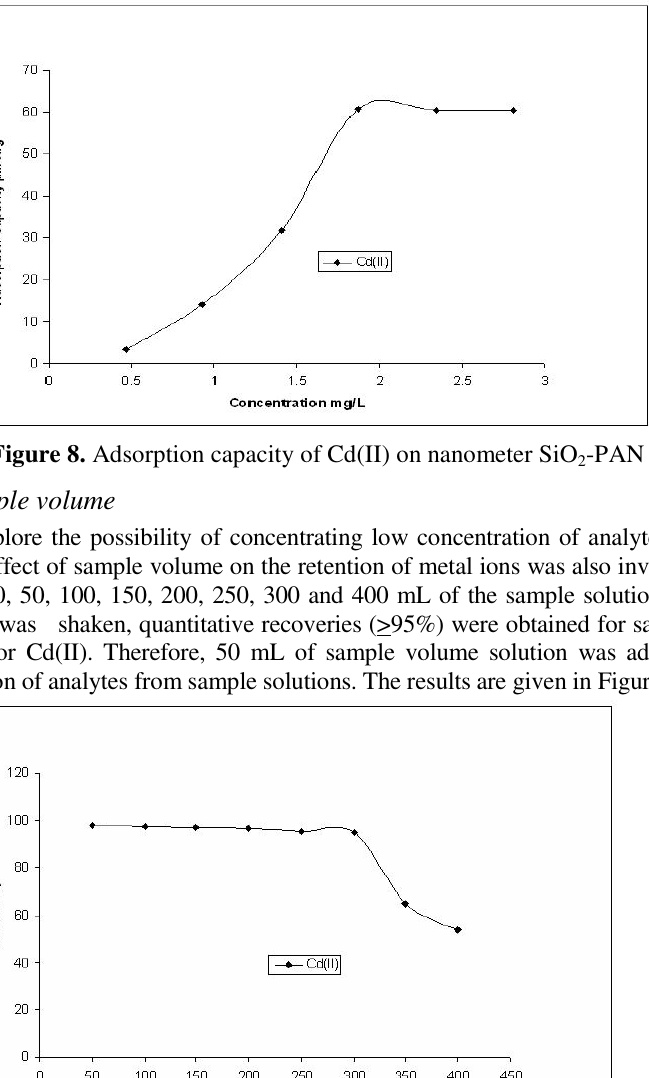
Figure 9. Effect of sample volume on analyte